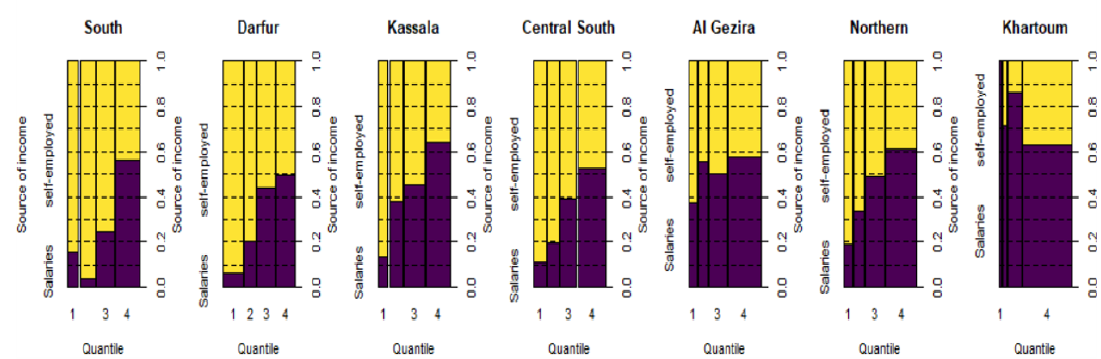
Figure 6. University attendance rates by income quartile for 19–21 year olds, by region.